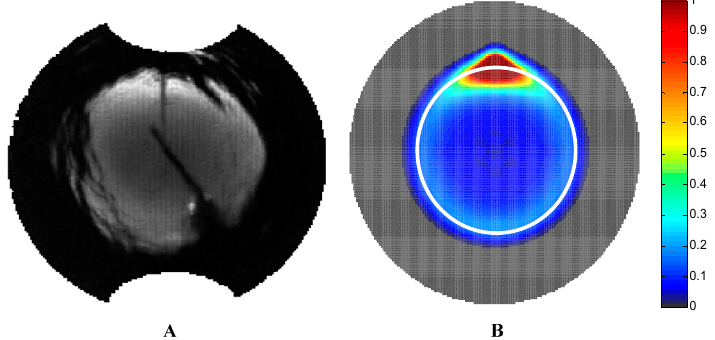
Figure 14. Radiance of downwelling light field. In this and the following figures, the zenith angle for the data increases linearly with the radius from the center. The sun is towards the top of the image and the solar zenith angle is 90°. ( A ) Data adopted from Bhandari’s work [24]; and ( B ) simulated results using our model. The white circle indicates the Snell’s cone.